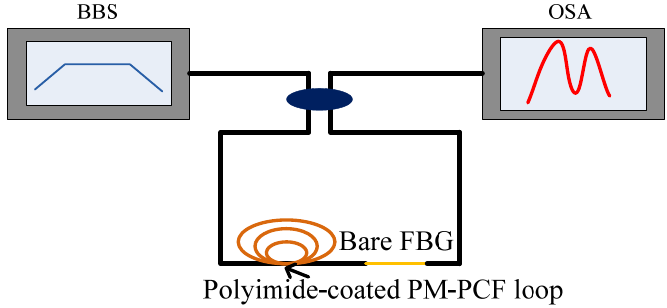
Figure 17. The sensor consists of FBG and salinity fiber [84].